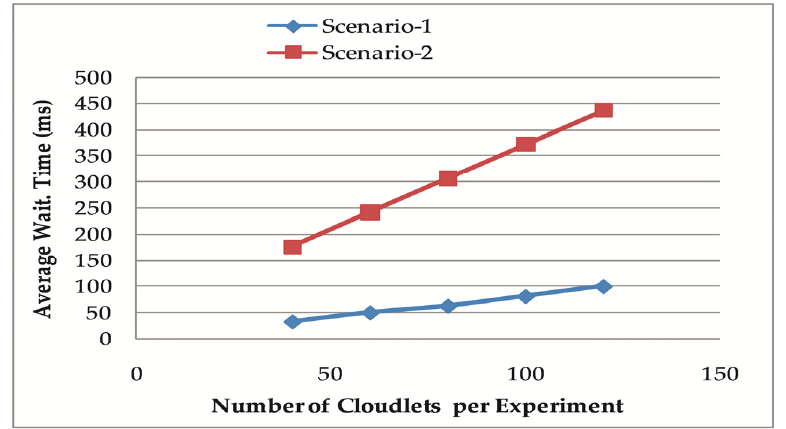
Figure 9. Average waiting time versus number of cloudlets.